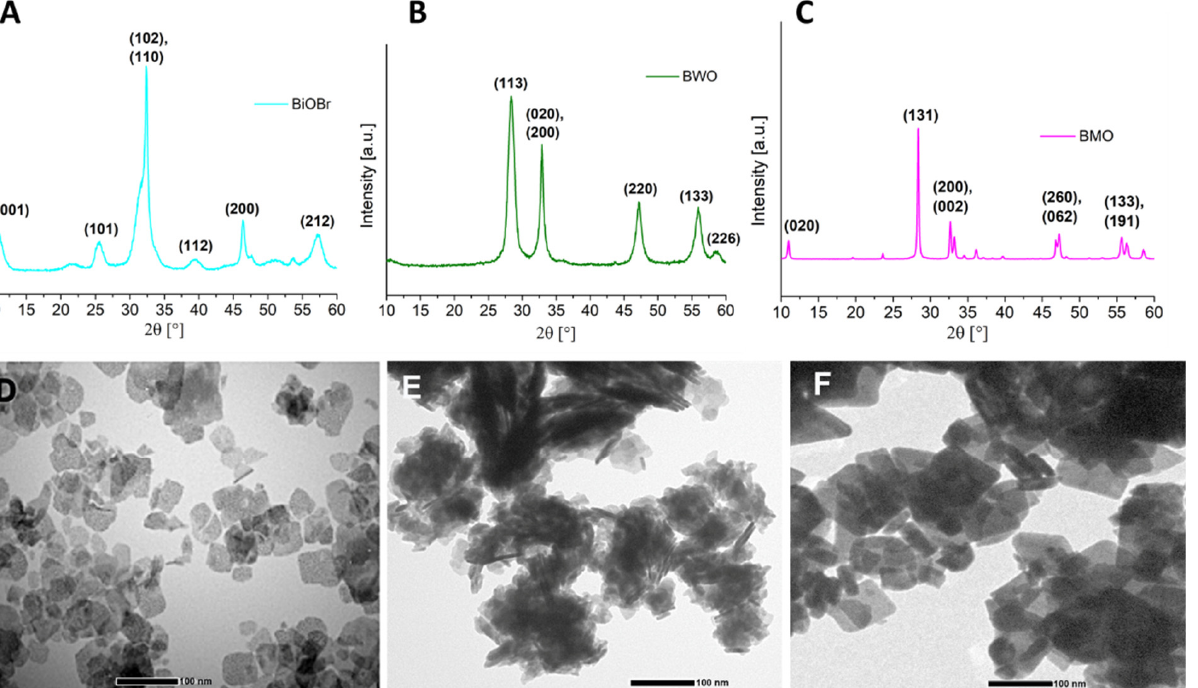
Figure 2. Crystallites size analysis of ( A ) BWO and ( B ) BMO with Williamson–Hall method. Table 1. Mean dimensions of crystallites (<DXRD>) are calculated from full width at half maximum (FWHM) of X-ray diffraction peaks a of BiOBr and BWO. Sample